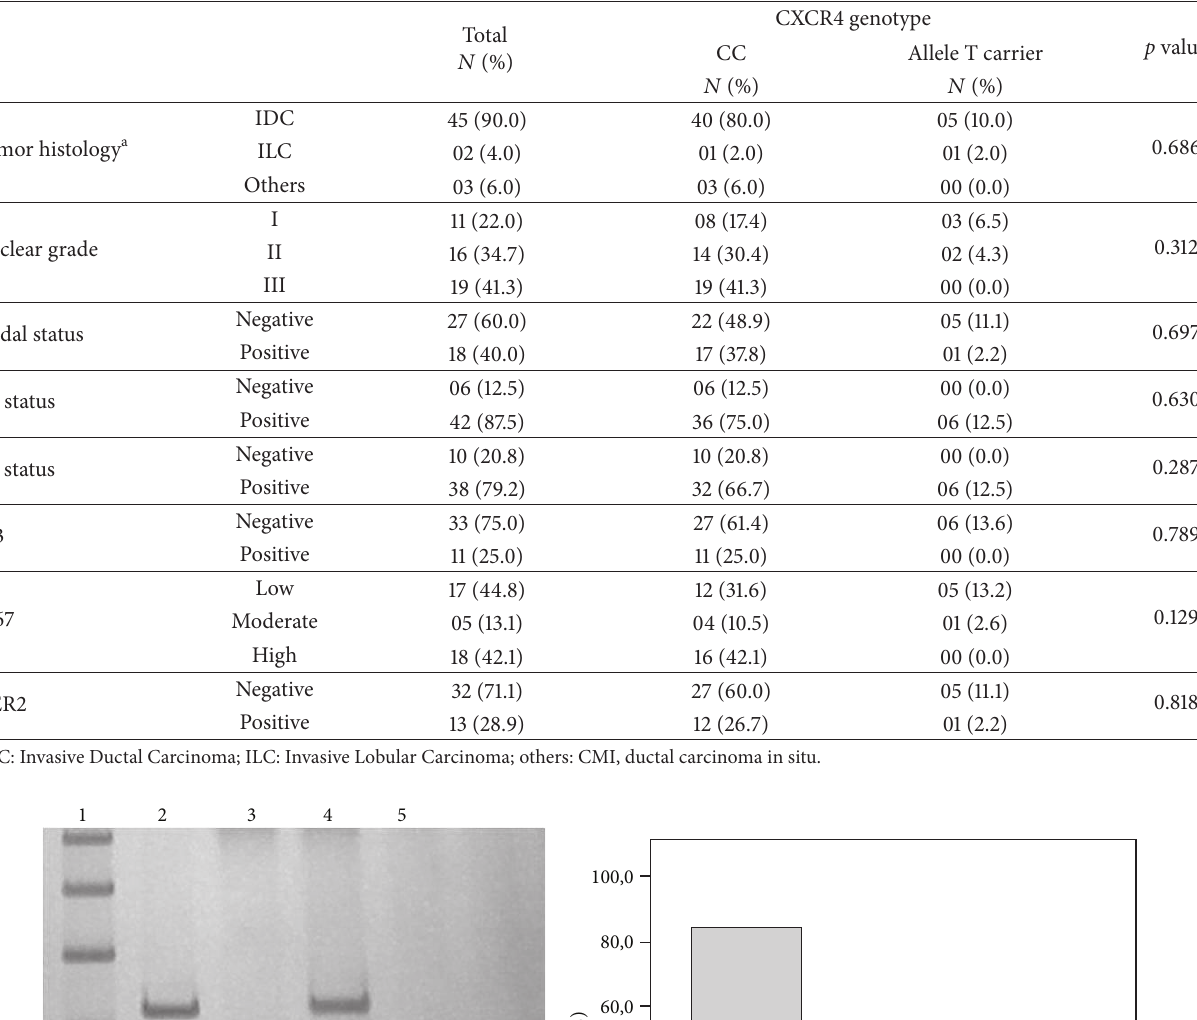
Table 2: Clinicopathological parameters analysis according to rs2228014 CXCR4 genetic polymorphism in breast cancer patients.